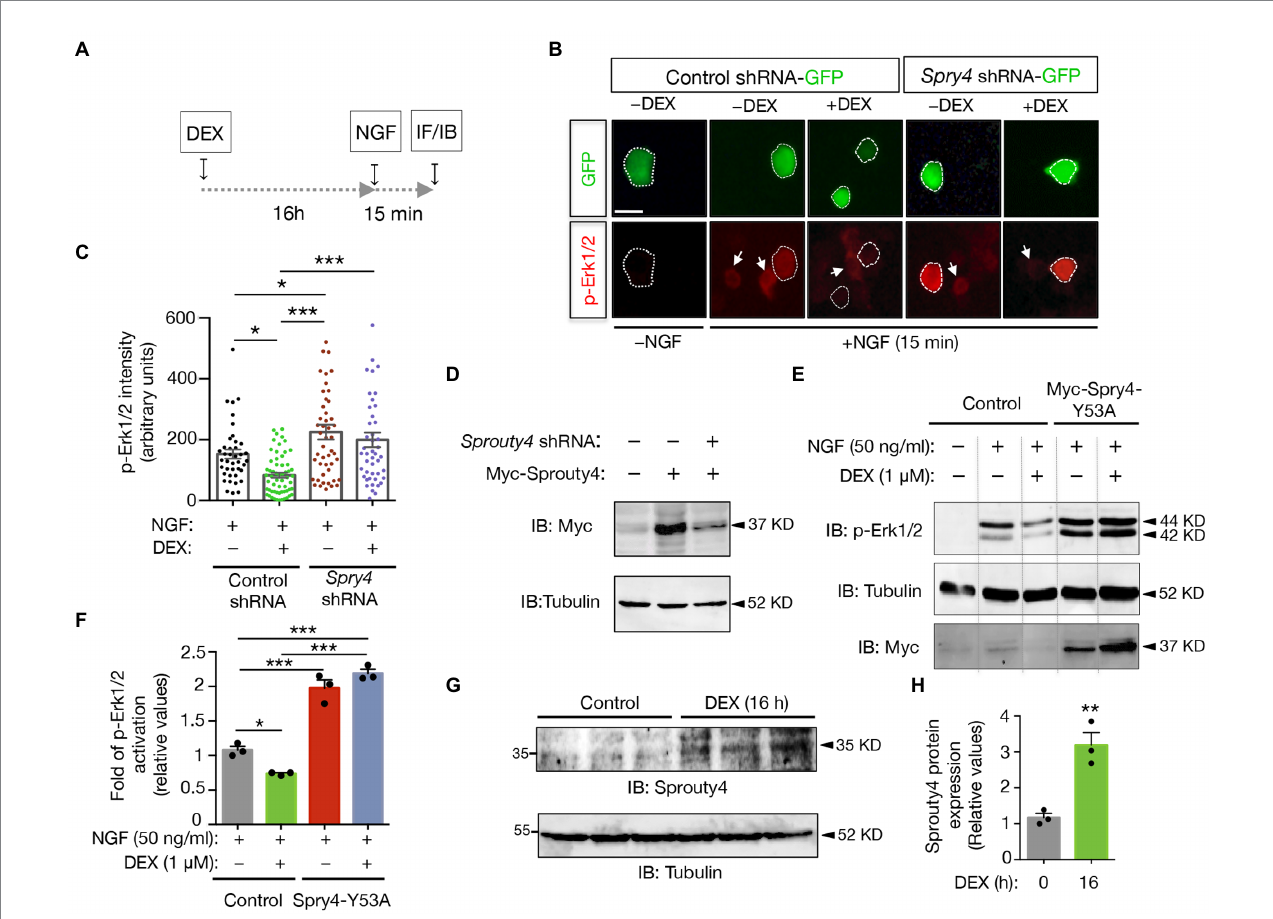
FIGURE 2 Sprouty4 mediates the inhibitory effect of DEX on NGF-induced Erk1/2 signaling. (A) Experimental schemes used to measure Erk1/2 phosphorylation in response to DEX and NGF treatments. Panels B and C show the evaluation of Erk1/2 activation by immunofluorescence (IF) and panels E and F by IB. (B) Photomicrographs show PC12 cells transfected with control-shRNA-GFP or Sprouty4 -shRNA-GFP plasmids. Cells were pretreated or not with DEX (1 μ M) for 16 h, stimulated for 15 min with NGF (50 ng/mL) and then fixed with 4% PFA. Activation of Erk1/2 was assessed by immunofluorescence (IF) of phospho Erk1/2 (p-Erk1/2) on GFP-positive cells labeled with dotted lines. Arrows indicate neighboring non-transfected cells. Scale bar, 15 μ m. (C) Graph showing individual values of p-Erk1/2 activation expressed as arbitrary units. 40–60 cells/experimental condition were evaluated. Data are mean ± s.e.m. of n = 3 independent assays. * p < 0.05, *** p < 0.001 by one-way ANOVA followed by Tukey’s multiple comparisons test. (D) Sprouty4 protein levels were analyzed by immunoblotting (IB) in MN1 cells transfected with control or Sprouty4-shRNA vector together with Myc-tagged Sprouty4. Tubulin is shown as loading control. (E) Representative IBs showing Erk1/2 activation (p-Erk1/2) in PC12 cell extracts transfected with control or Myc-tagged Sprouty4-Y53A (Myc-Spry4-Y53A) constructs. Cells were pretreated or not with DEX (1 μ M) for 16 h, and then stimulated for 15 min with NGF (50 ng/mL). Reprobing of the same blot with anti-Tubulin and anti-Myc are shown. Dotted lines indicate representative bands cut from the same immunoblot image. (F) Quantification of the fold of p-Erk1/2 activation relative to control cells only treated with NGF for 15 min (gray bar). Values are mean ± SD of n = 3 independent assays. * p < 0.05, *** p < 0.001 by one-way ANOVA followed by Tukey’s-test. (G) Immunoblot showing increased Sprouty4 protein levels upon 16 h of DEX treatment. Reprobing of the same filter with anti-Tubulin is shown as loading control. (H) Quantification of the levels of Sprouty4 expression in control and DEX- treated cells for 16 h. Values are expressed relative to the untreated control group. Bars represent mean ± SD of n = 3 independent samples. ** p < 0.01 by Student ʼ s t